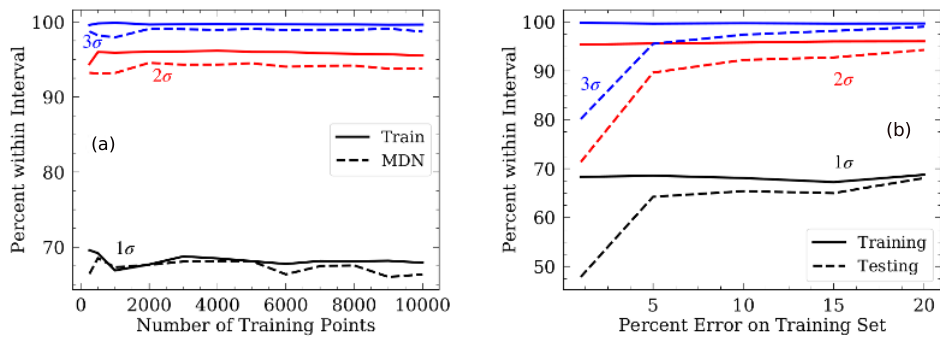
Figure 1. Percentage of the training set (solid lines) and MDN validation (dashed lines) that fall within 1 σ (black), 2 σ (red), and 3 σ (blue) of the mean value for (a) the number of samples in the training set and (b) percentage error on mass yields used to construct the training set of 3000